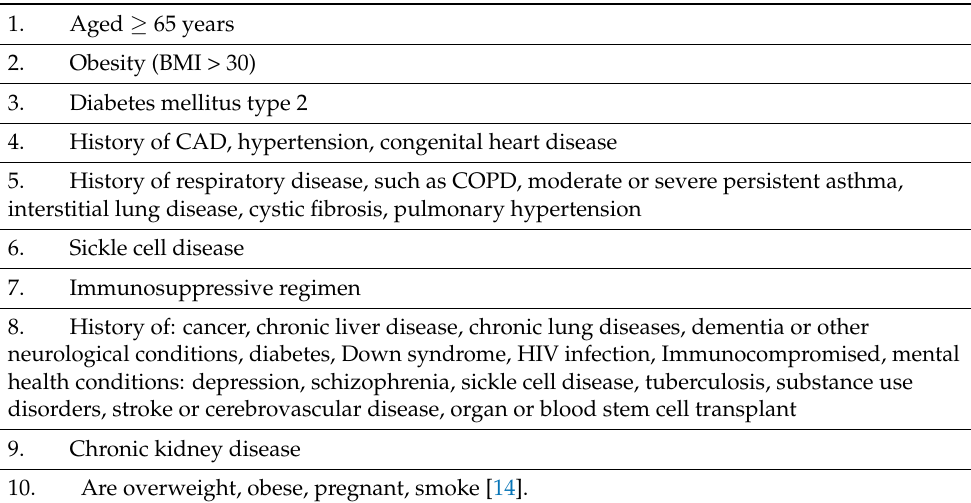
Table 1. Risk factors for progression to severe disease based on FDA and NIH